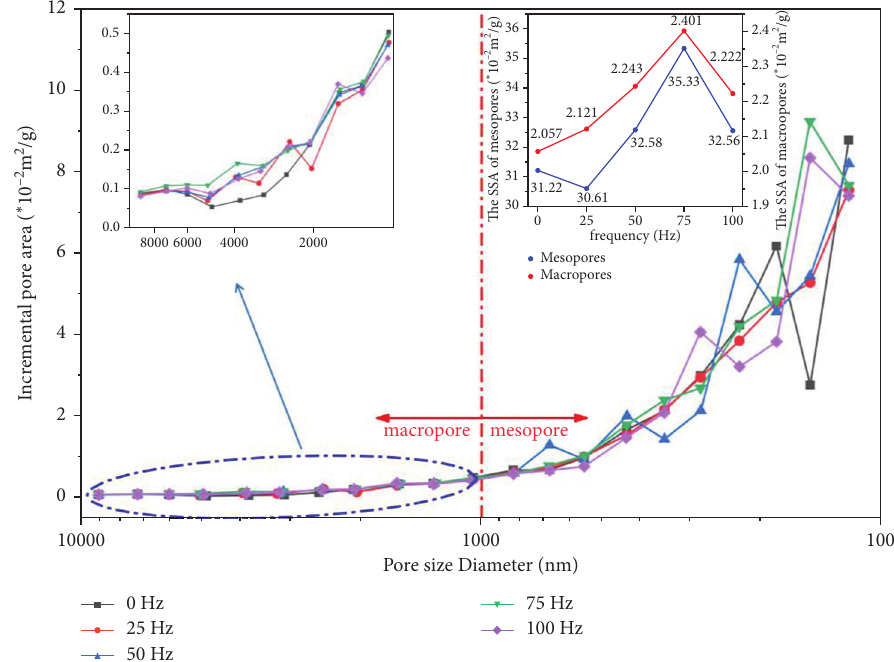
Figure 5: The SSA distribution of macropores and